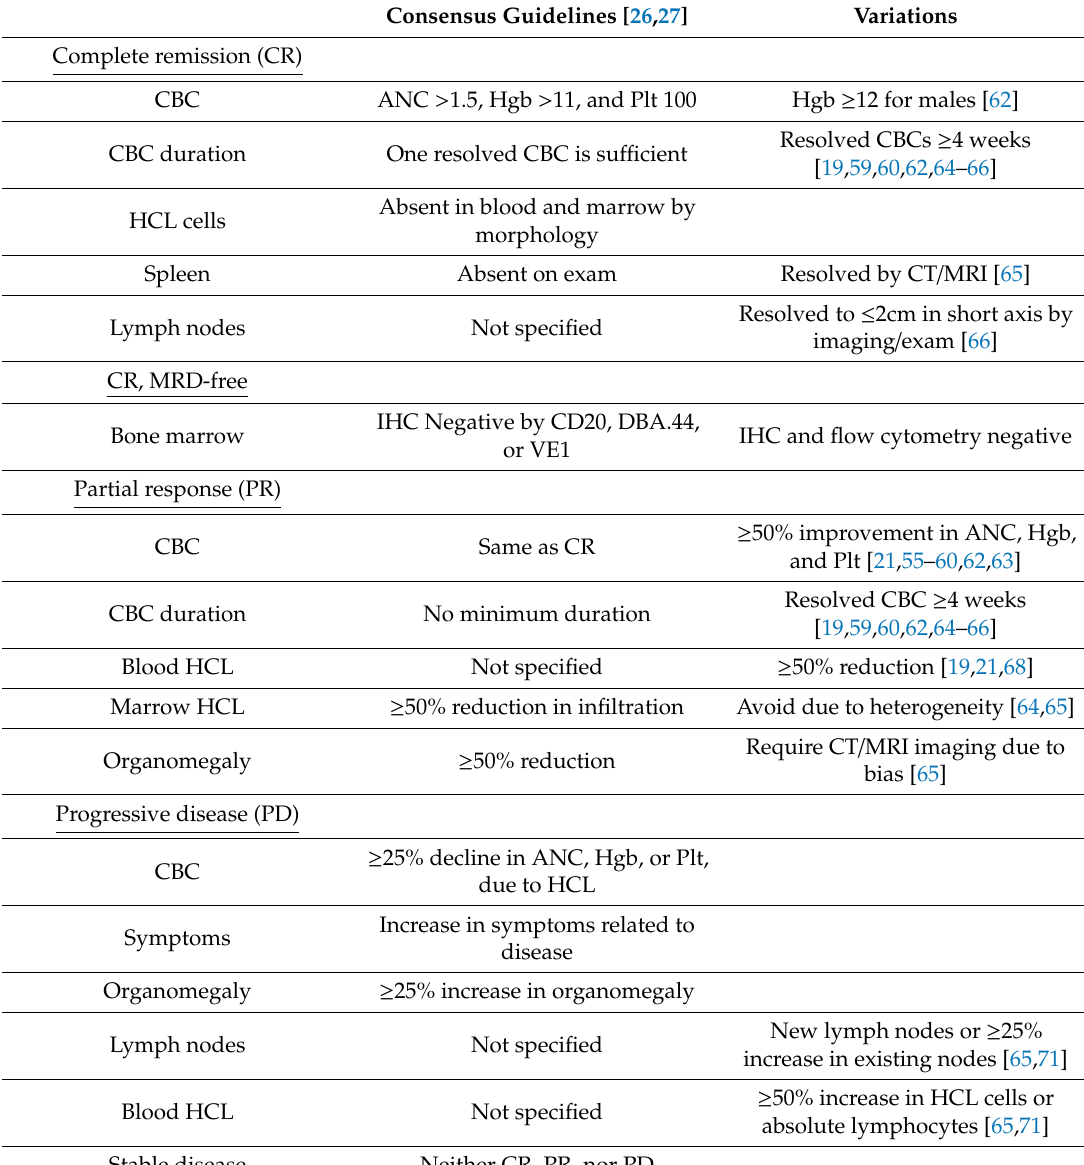
Table 1. Criteria for response in hairy cell leukemia